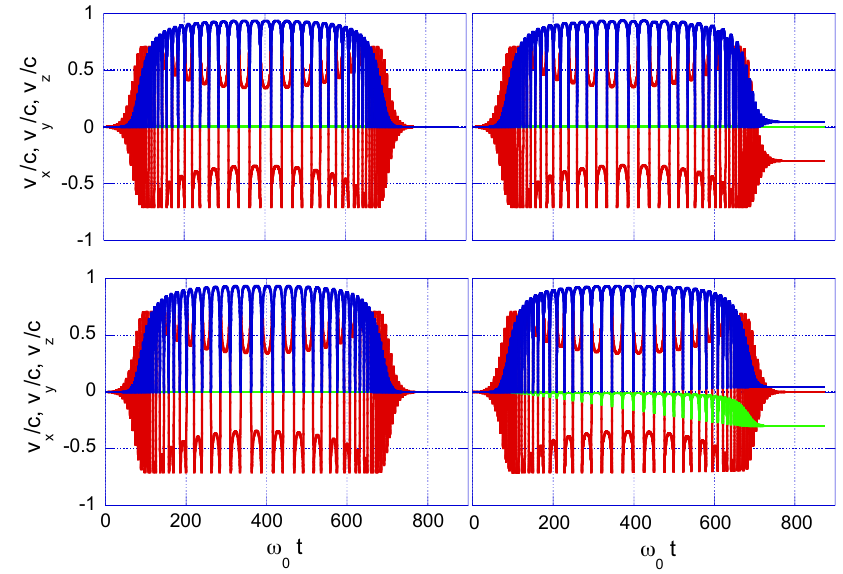
Figure 11. Left column, temporal evolution of velocity components for paraxial fields (top panel) √ versus analytical solution (bottom panel), x 0 = w 0 / 2, y 0 = 0: quantitative agreement is excellent in this case. Right column, top panel, x 0 = 65.0 µ m, y 0 = 0. bottom panel, y 0 = 65.0 µ m, x 0 = 0. No precise quantitative match with the analytical solution is found now. Color code is red, green and blue for v x / c , v y / c and v z / c respectively. Temporal axis is given as the dimensionless product ω 0 × t